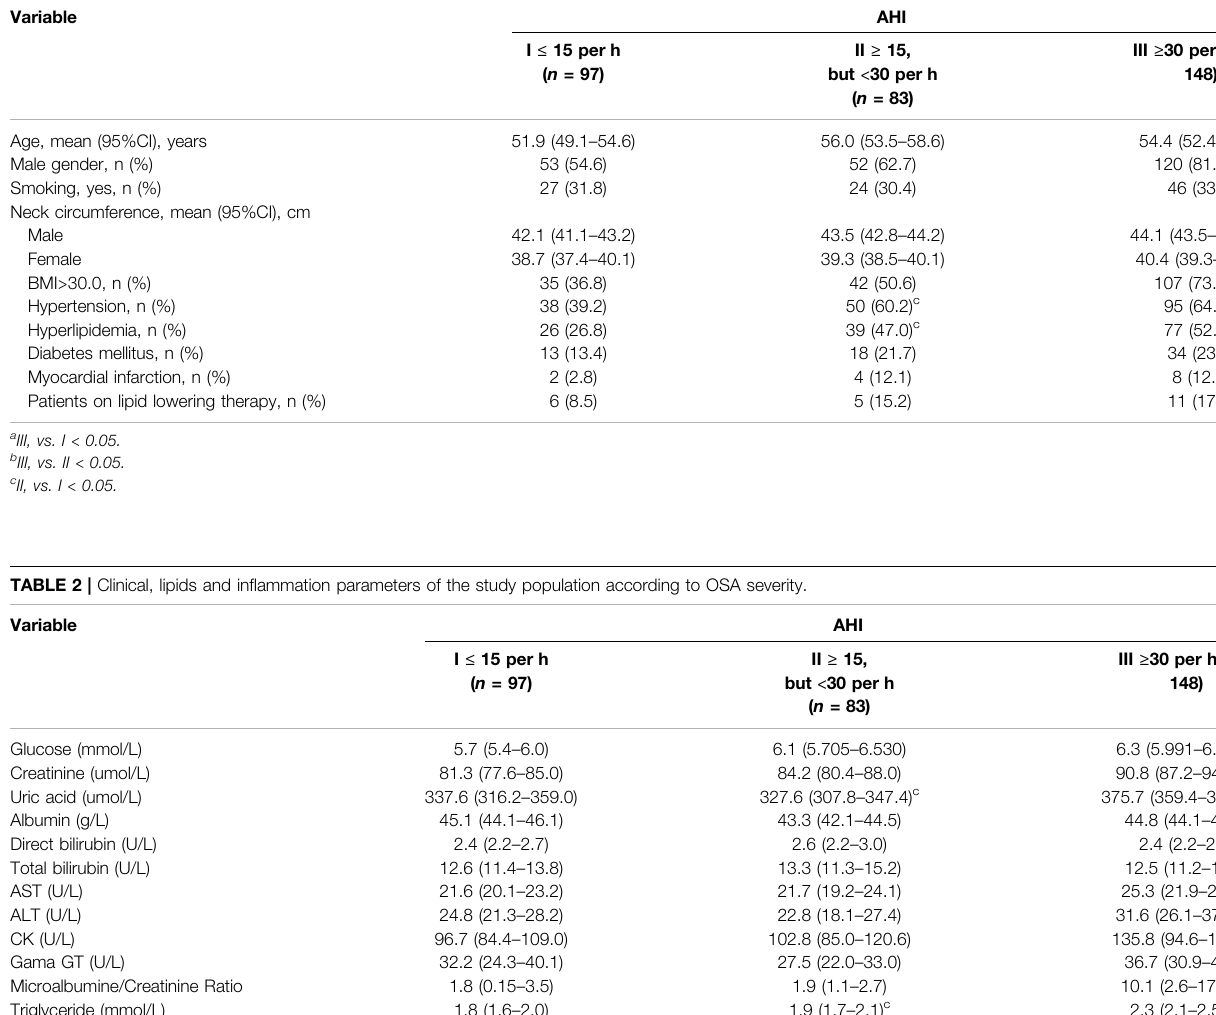
TABLE 1 | Demographic data and comorbidities of the study population according to OSA severity.